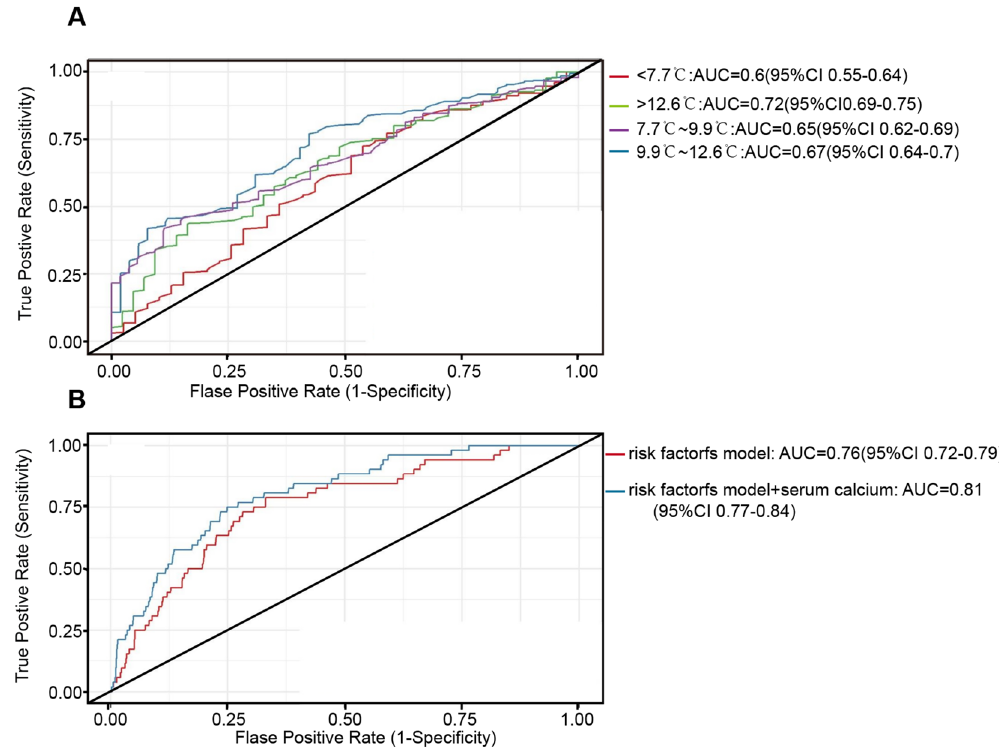
Figure 4. The area under the receiver operating characteristic curve (ROC AUC ) of serum calcium concentration in the prediction of in-hospital mortality among patients with acute myocardial infarction stratified by quartiles of DTR (A). Compared with other quartiles of DTR, the independent ROC AUC for serum calcium concentration in the highest quartile of DTR was 0.72 (95% CI, 0.69–0.75; P < 0.001). Multivariate combined ROC AUC , which was estimated using a regression model that included age, gender, current smoking, current alcohol use, diabetes mellitus, high-density lipoprotein cholesterol, uric acid, serum phosphate, serum potassium, left ventricular ejection fraction and left atrial diameter, with or without serum calcium among patients in the highest DTR quartile (B). The combined predictive values with and without serum calcium concentration were 0.81 (95% CI, 0.76–0.84; P < 0.001) and 0.76 (95% CI, 0.72–0.79; P < 0.001), respectively. AUC, area under the curve; CI, confidence